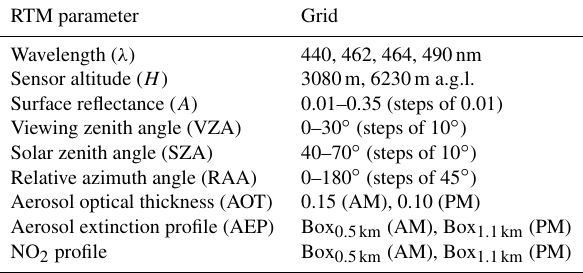
Table 4. Overview of the input parameters in the radiative transfer model DISORT, characterising the air mass factor look-up